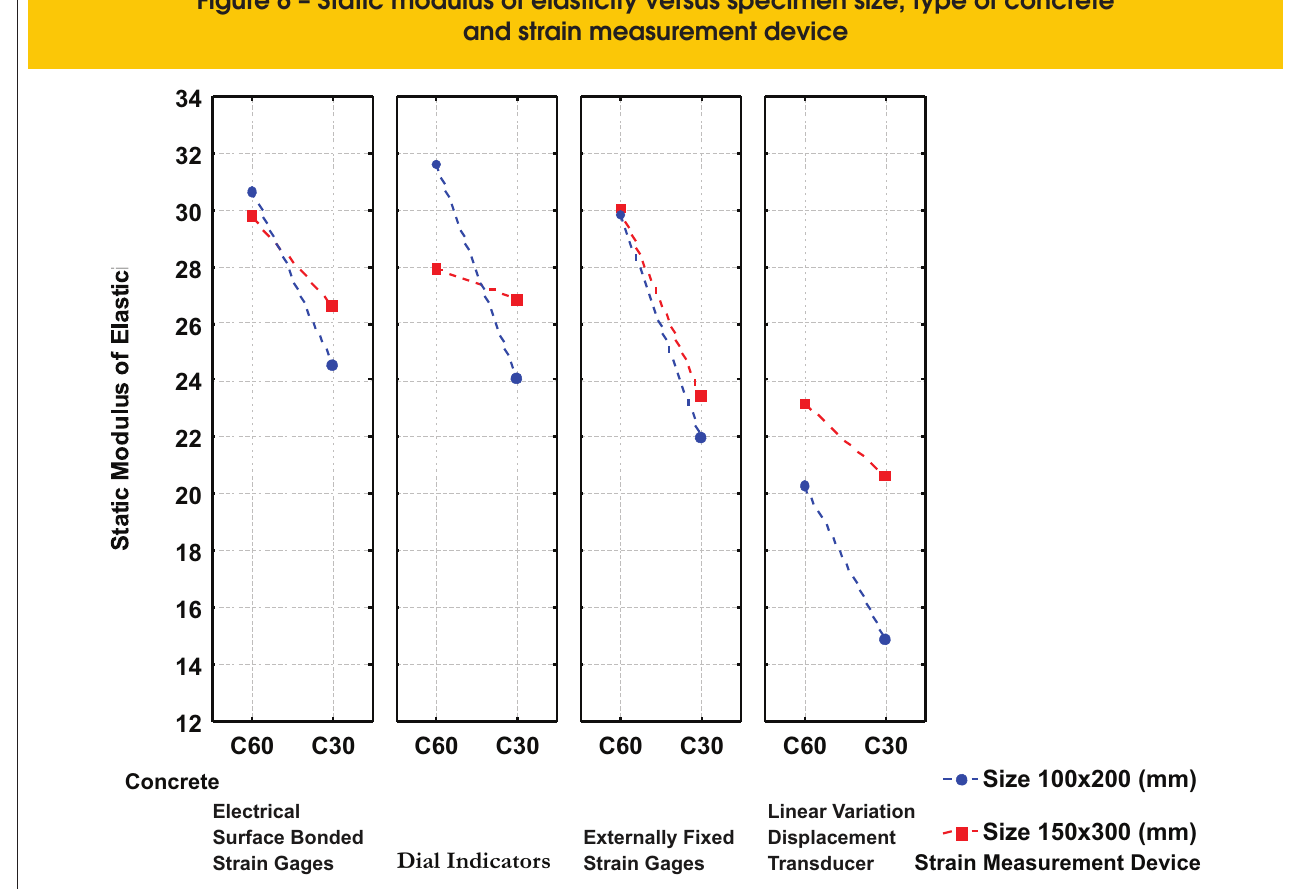
Figure 6 – Static modulus of elasticity versus specimen size, type of concrete and strain measurement